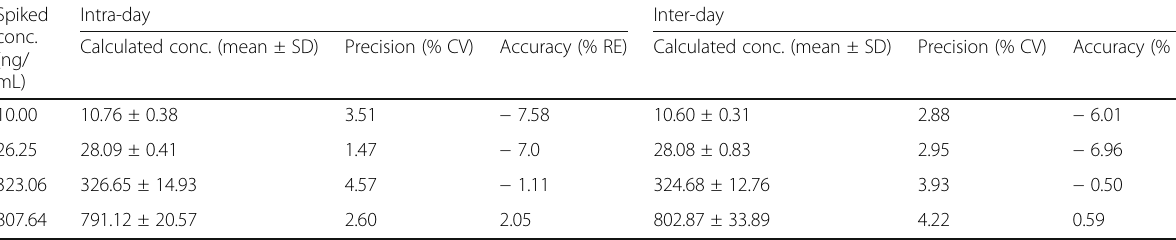
Table 1 Precision and accuracy results for lenalidomide in human plasma Spiked